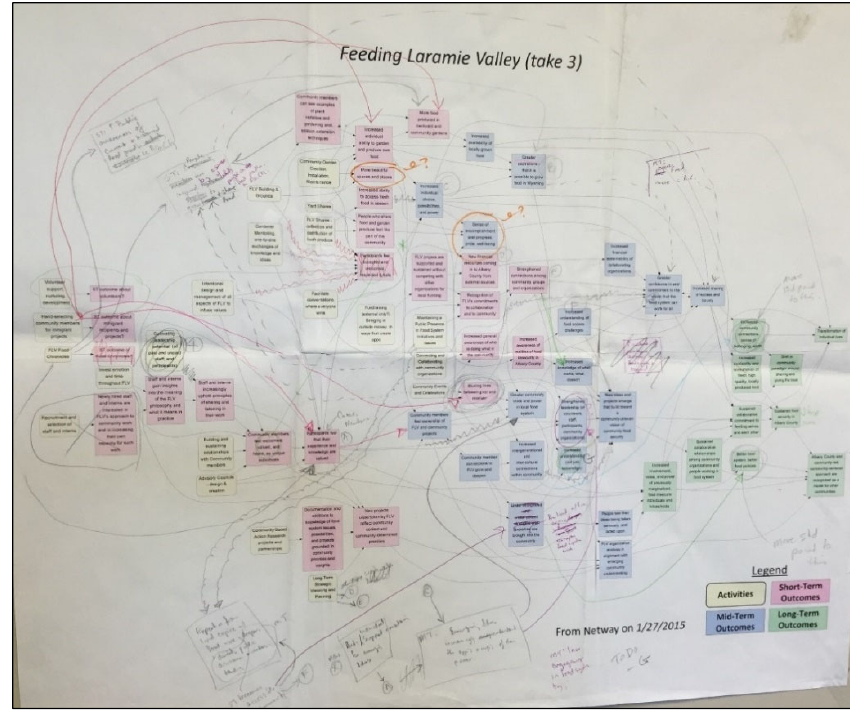
Figure 2. Illustration of One Round of Revisions Based on Community Partner